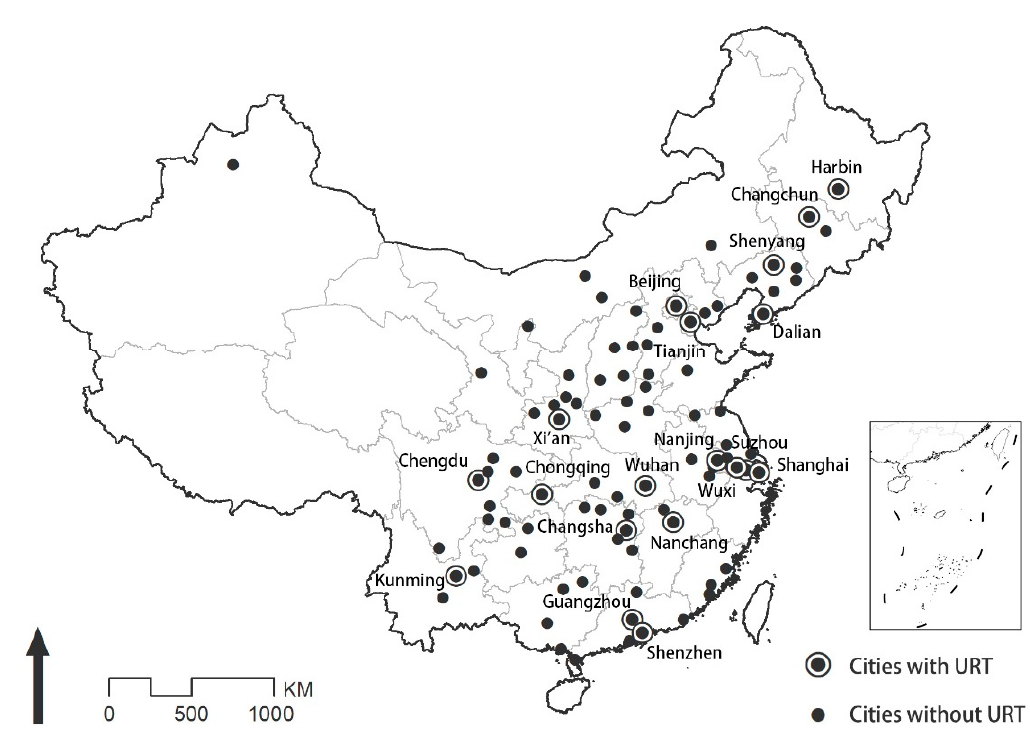
Figure 3. Spatial distribution of 90 sample prefecture-level cities in 2015. Source: Created by the authors from the China Association of Metros [38].